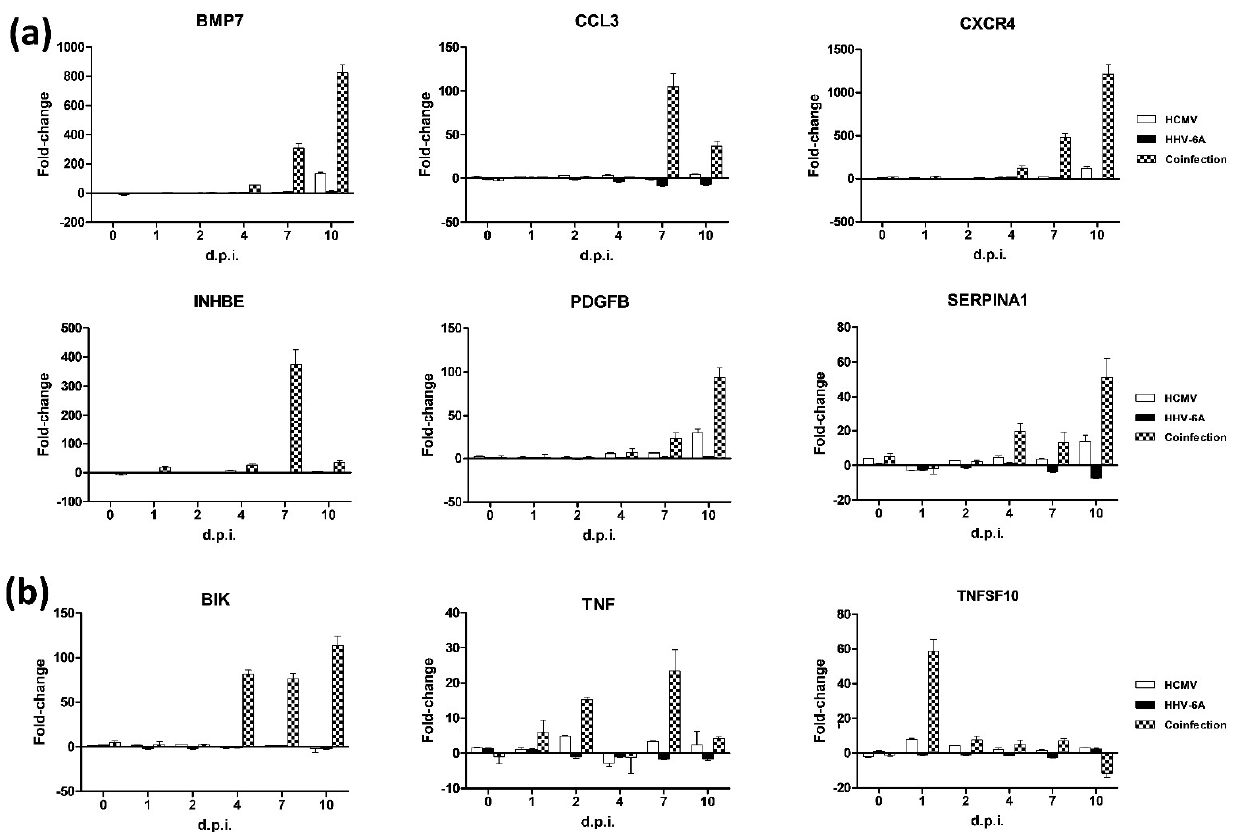
Figure 4. Factors uniquely or mostly affected by viruses’ coinfection. ( a ) Fibrosis-associated factors; ( b ) apoptosis-associated factors. Results are expressed as mean values ± S.D. of duplicate samples in two independent experiments.